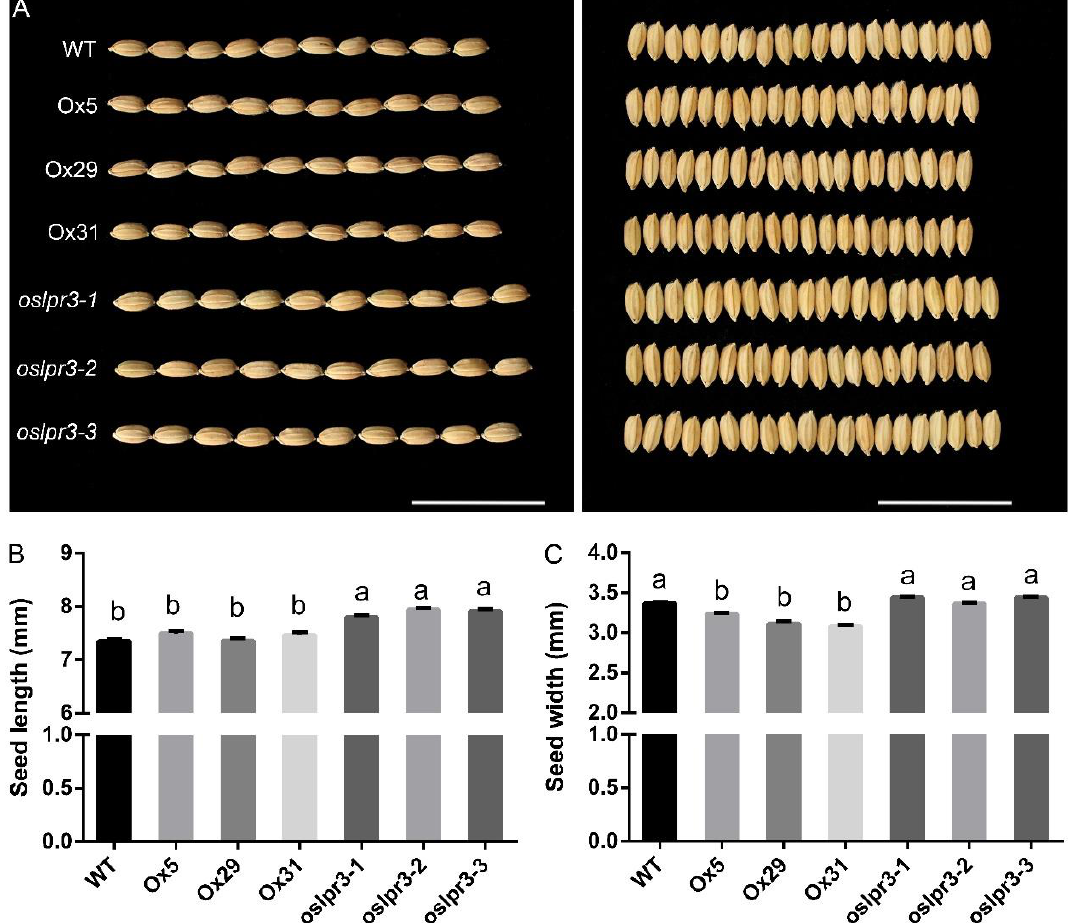
Figure 5. Alteration of OsLPR3 expression affects seed length and width. WT, OsLPR3 -Ox, and oslpr3 lines were grown as described in the legend in Figure 6. ( A ) Photographs of the seed phenotype. Scale bar = 3 cm. ( B , C ) Seed length and seed width, respectively. Values are means ± SE ( n = 30). Different letters above the bars indicate significant differences ( P < 0.05, one-way ANOVA).